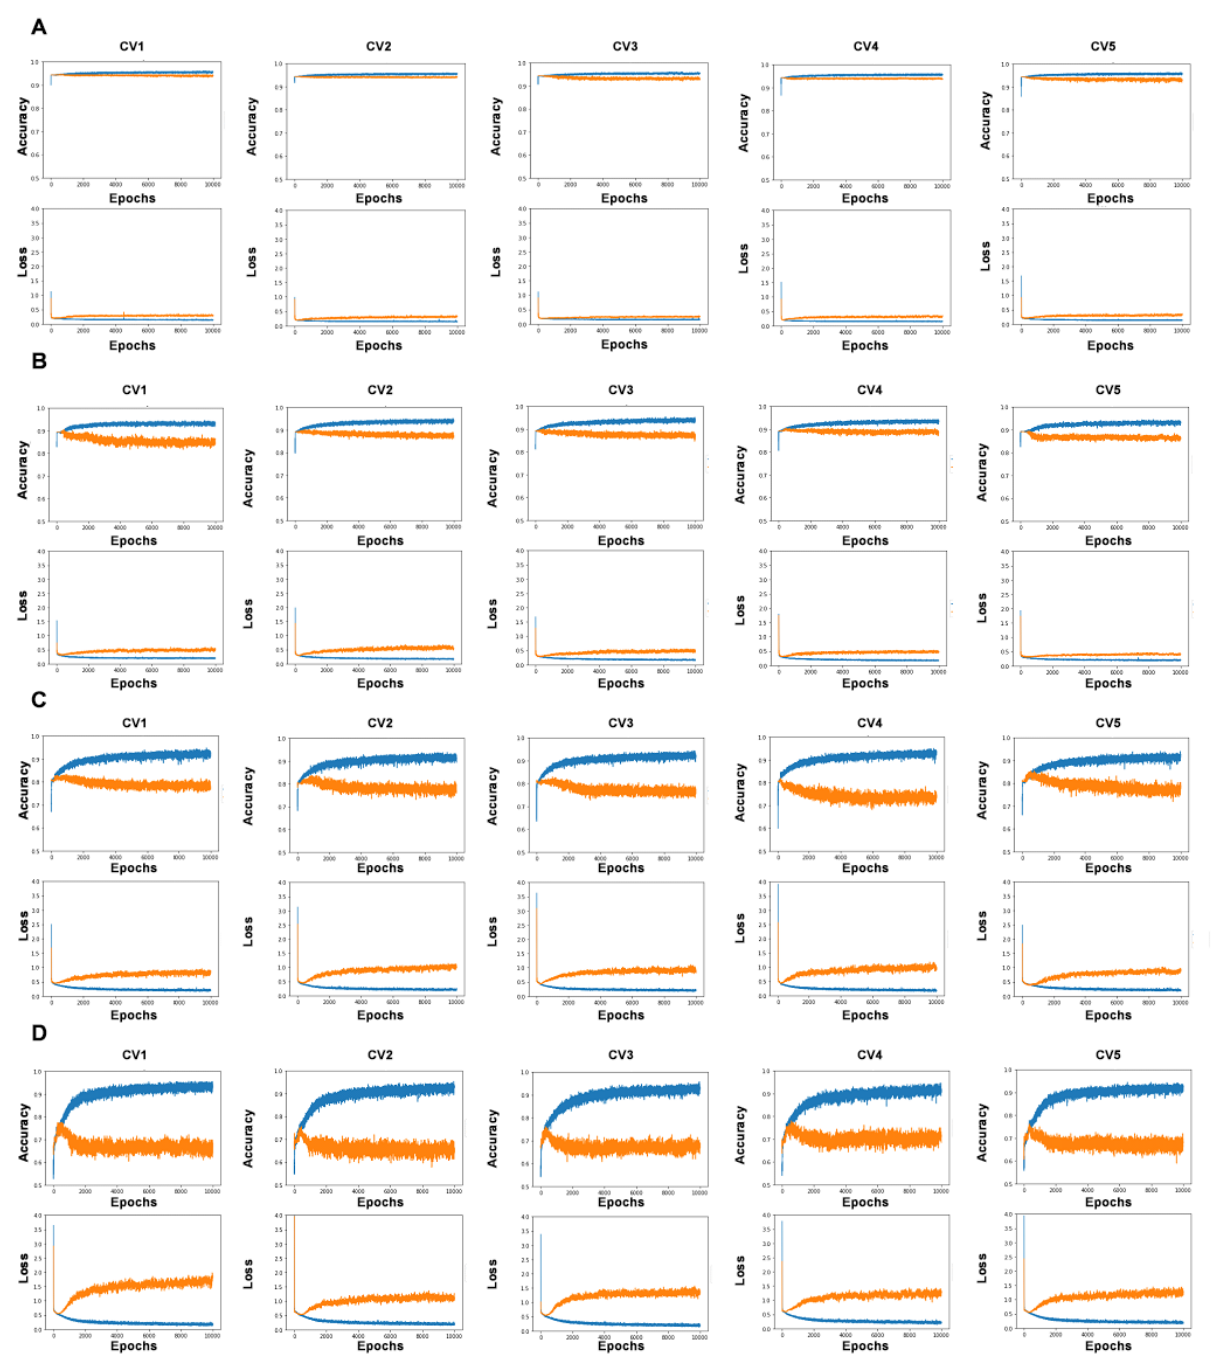
Figure 2. Learning curve analysis. (A) No undersampling. (B) Sampling ratio of 1:2. (C) Sampling ratio of 1:4. (D) Sampling ratio of 1:8. The top row shows the association between accuracy and number of epochs, and the bottom row shows the association between cross-entropy loss and number of epochs; the blue and orange lines show the results of training and validation, respectively. CV: cross-validation.